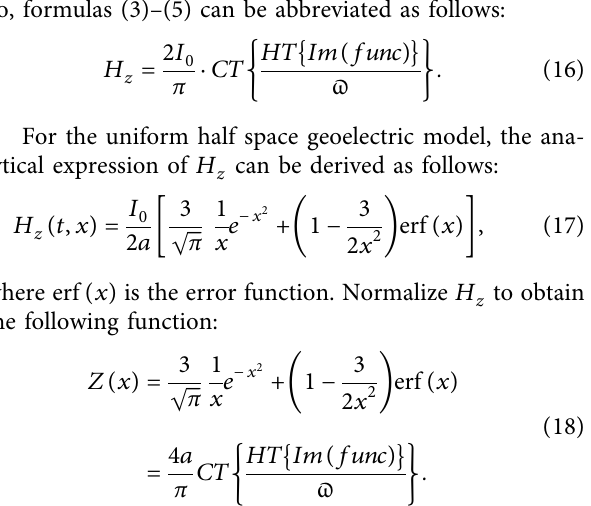
Figure 6: Inversion results of the QPSO-CLS joint algorithm, (a) model fitting curve, and (b) fitting curve of attenuation voltage. HT ∗ { } , and the cosine transform is represented by CT ∗ { } .